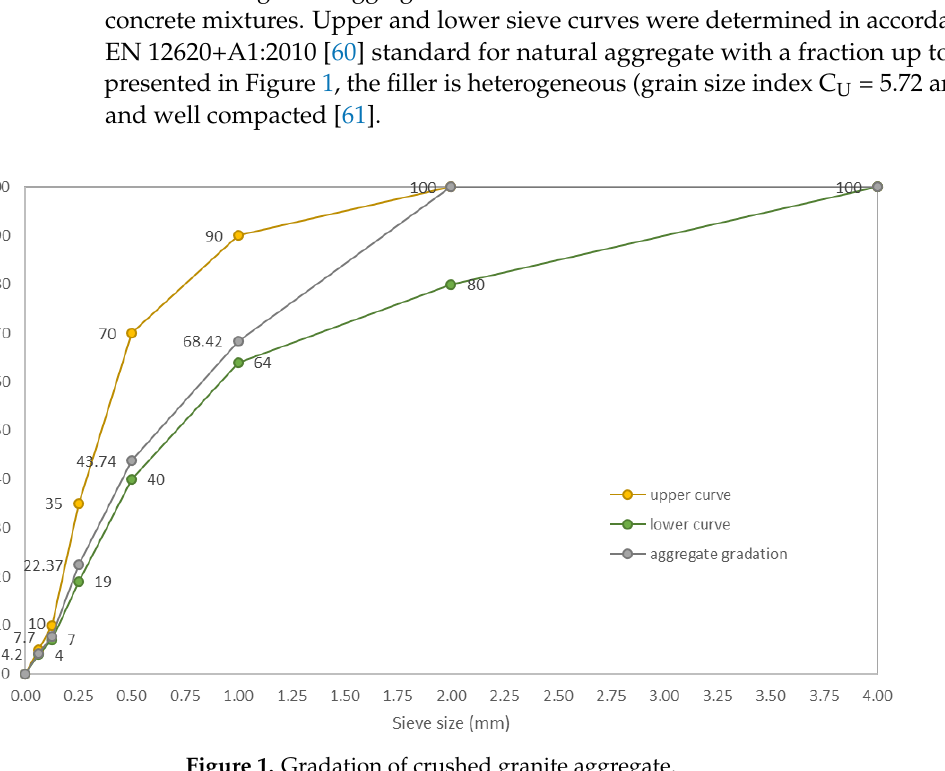
Figure 1. Gradation of crushed granite aggregate.